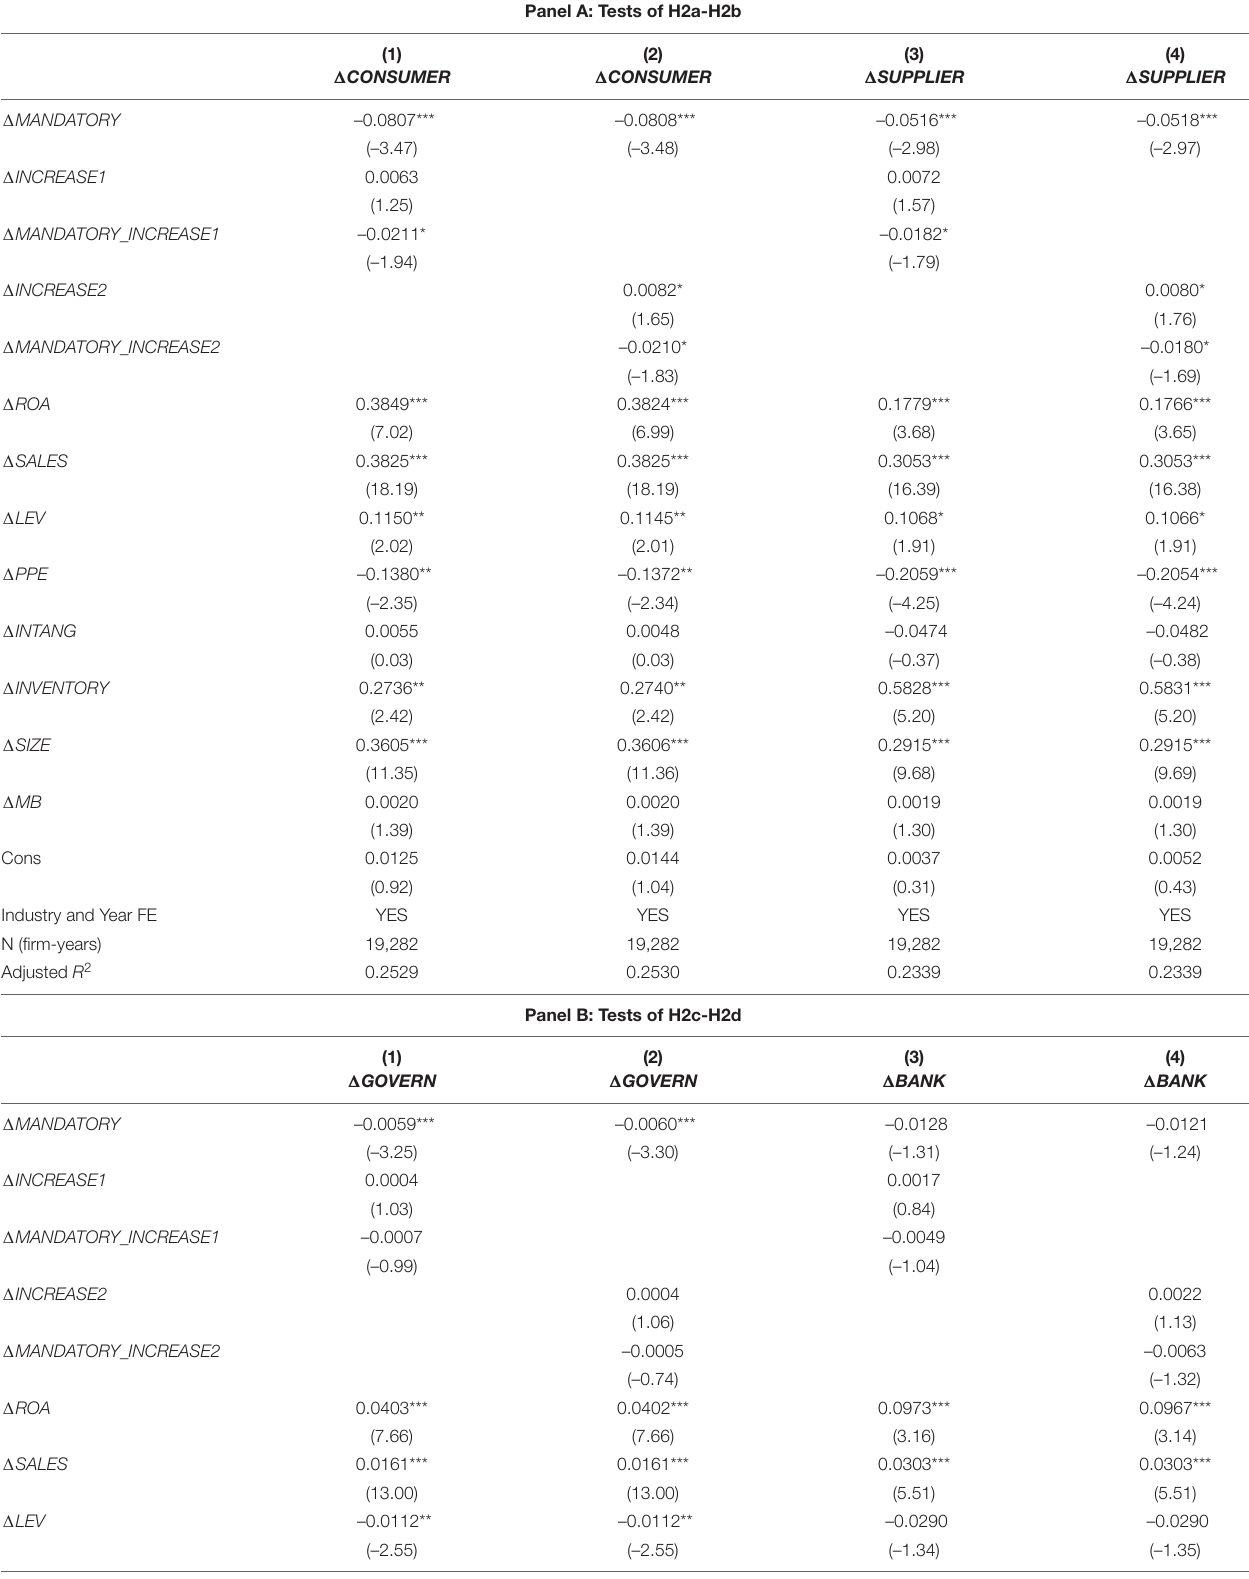
TABLE 3 | Test of